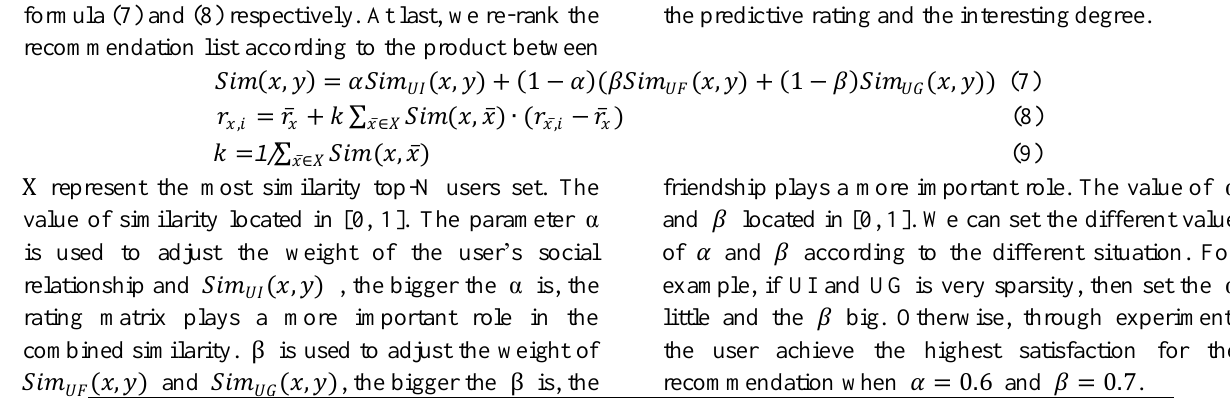
Algorithm3 Personalized recommendation Algorithm: Personalized semantic search